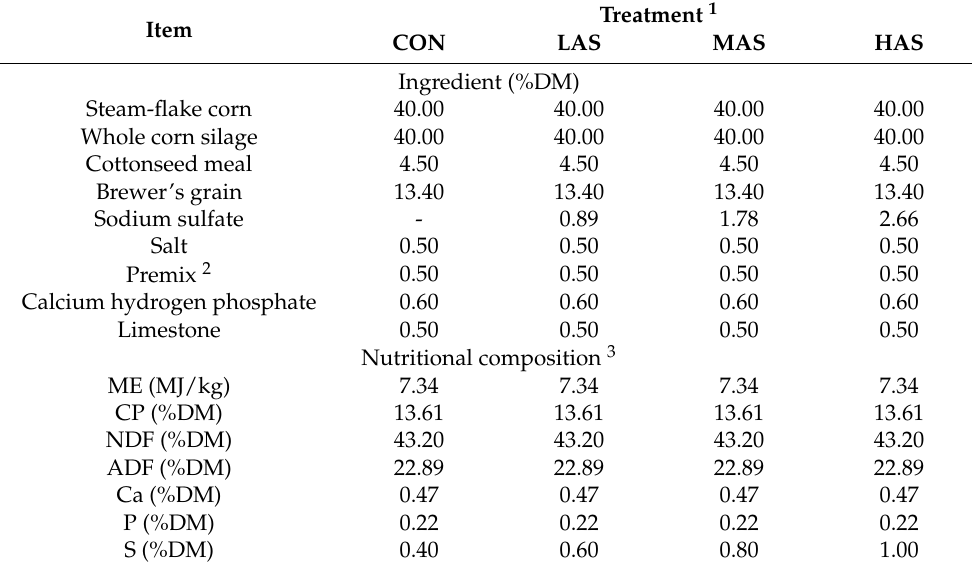
Table 1. Basic diet composition and nutrition